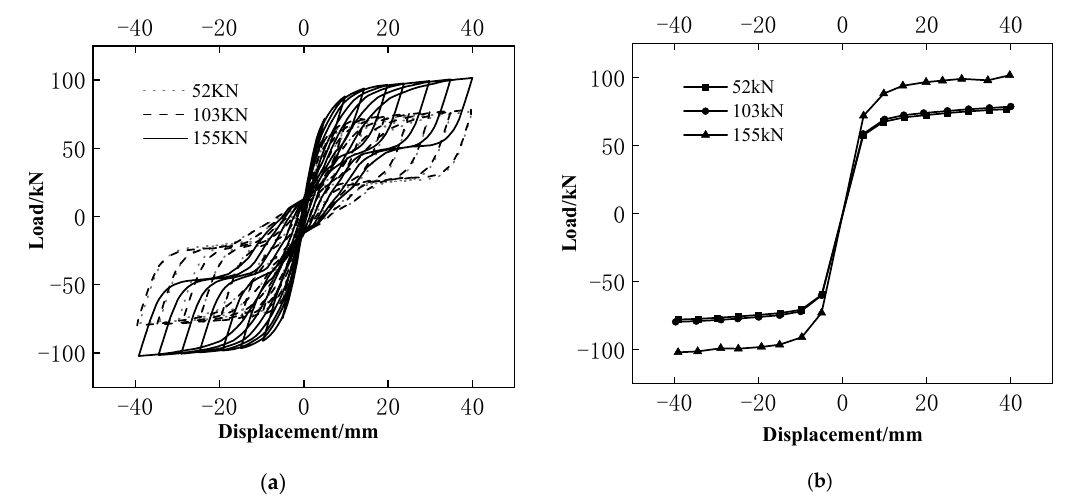
Figure 14. Comparison diagram of hysteretic characteristics. ( a ) Hysteretic curve under different prestress. ( b ) Skeleton curve under different prestress sizes.